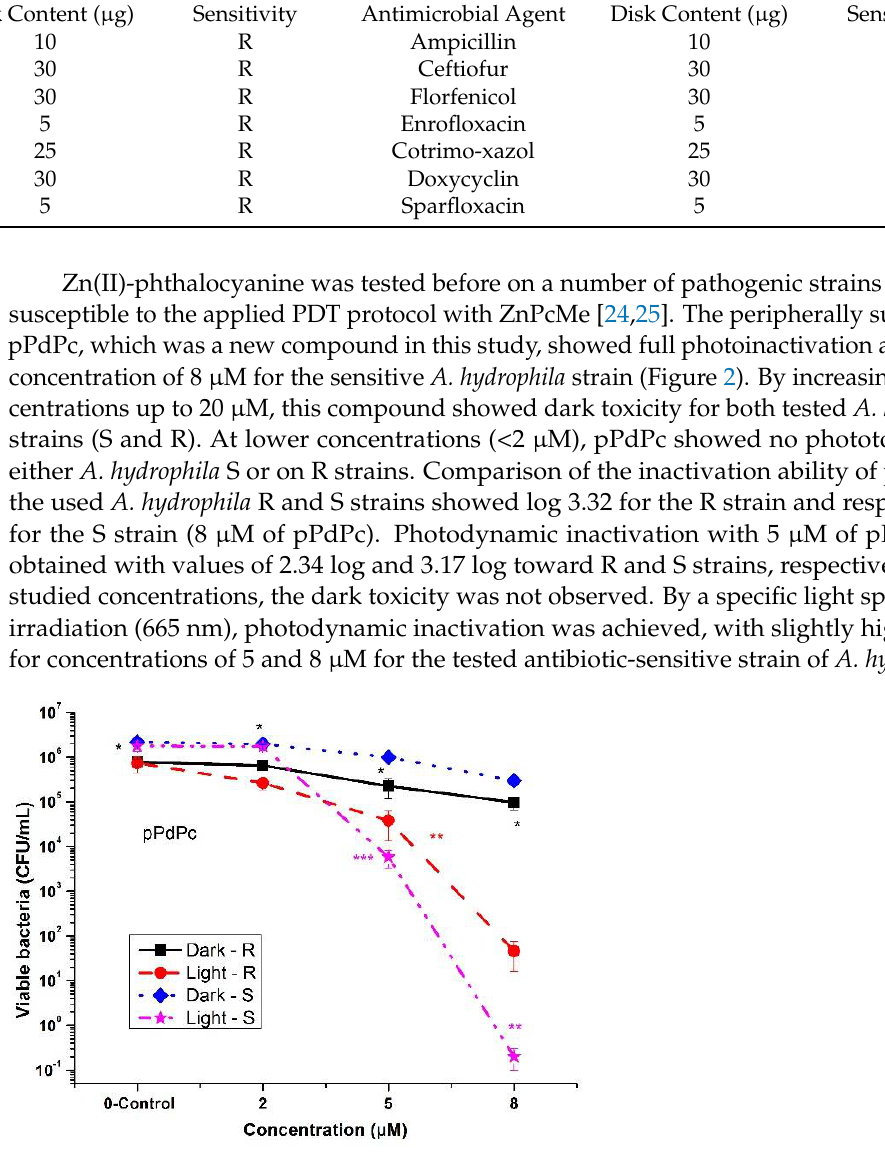
Figure 3. Uptake of Pd(II)-phthalocyanine (pPdPc) in A. hydrophila ( R and S ) strains as suspensions with different cell densities as obtained by fluorescence measurements. The well-explored